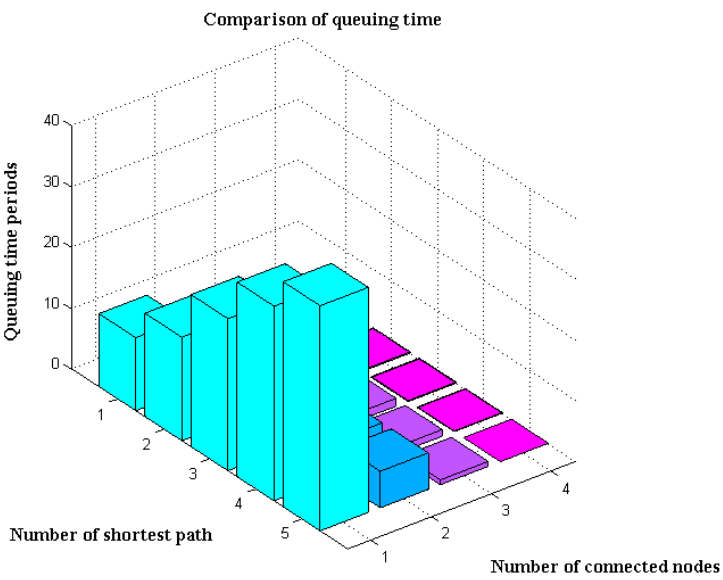
Figure 6. Queuing time periods.